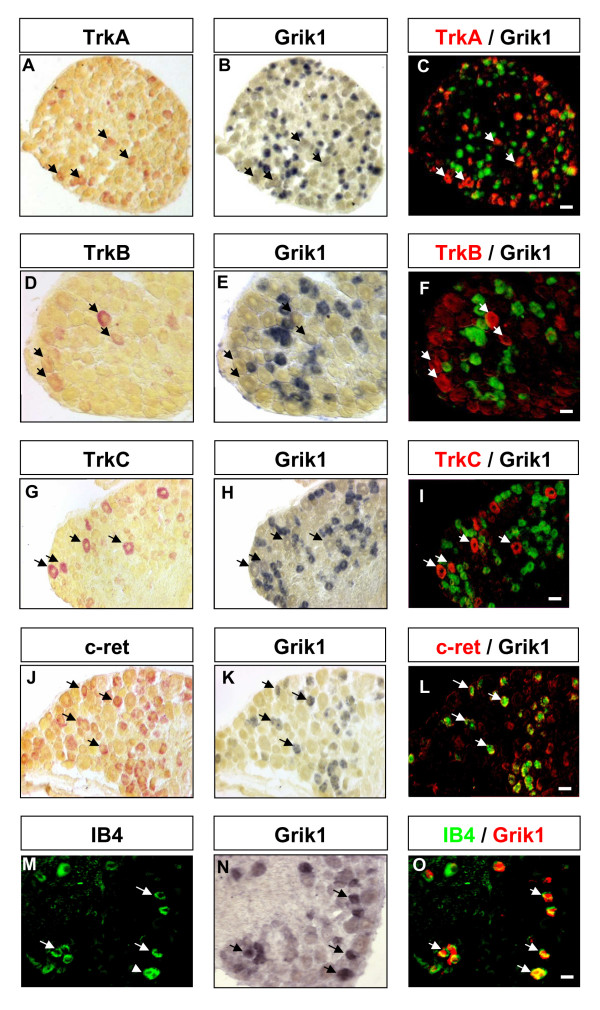
Co-localisation Grik1/GluR5 mRNA with markers of defined sub-populations of sensory neurons: Double in situ hybridization was carried out on sections of adult DRG by using fluorescein/fast red detection for TrkA (A), TrkB (D), TrkC (G), c-ret (J) and immunohistochemical detection of isolectin B4 (M). Grik1/GluR5 mRNA was subsequently detected using DIG/NBT-BCIP detection in B, E, H, K, N. In situ signals were converted into pseudo colors and images were superimposed (C, F, I, L, O) to show co-labelling of cells. Grik1/GluR5 was excluded from TrkA, B and C population but was co-localised with c-ret and isolectin B4 neurons. Scale bar 50 μm.